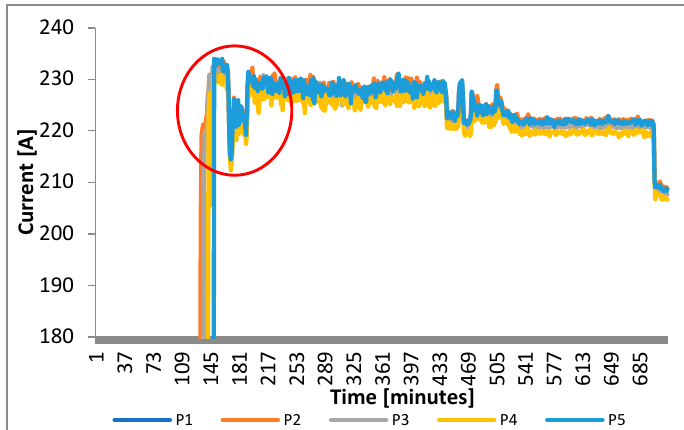
Figure 5. Current values during one day.